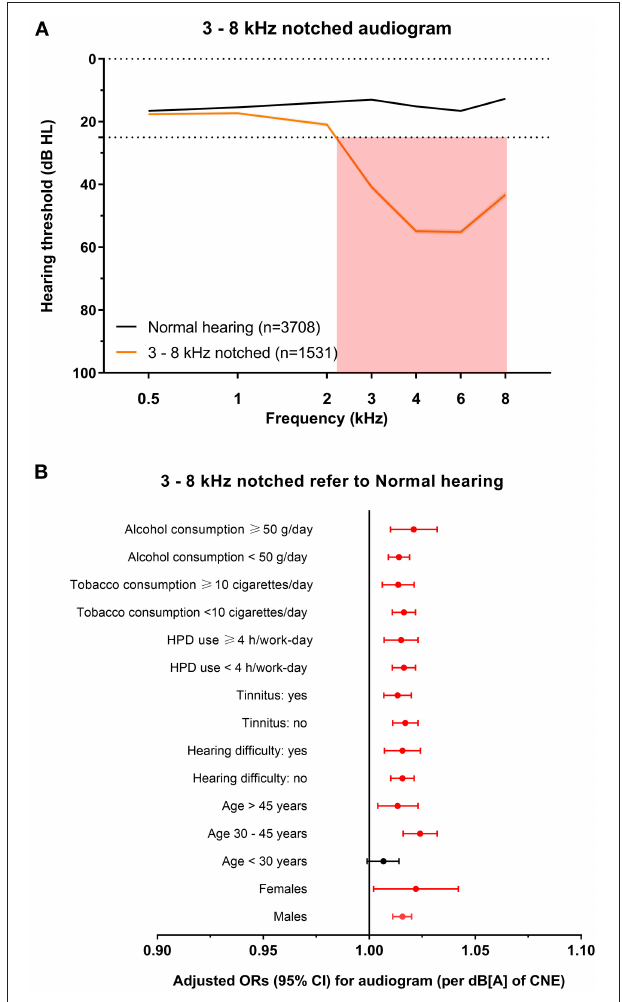
FIGURE 5 | The 3–8kHz notched audiogram and its association with noise exposure. (A) The average hearing thresholds over 0.5–8kHz frequencies of subjects with normal hearing and the cluster of 3–8kHz notched audiogram. The pink shade includes the range of notched frequencies. (B) Adjusted ORs with 95% CI of CNE increment (per dB[A]) for the 3–8kHz notched audiogram refer to normal hearing audiogram after stratification of sex, age, hearing difficulty, tinnitus, HPD use, tobacco consumption, and alcohol